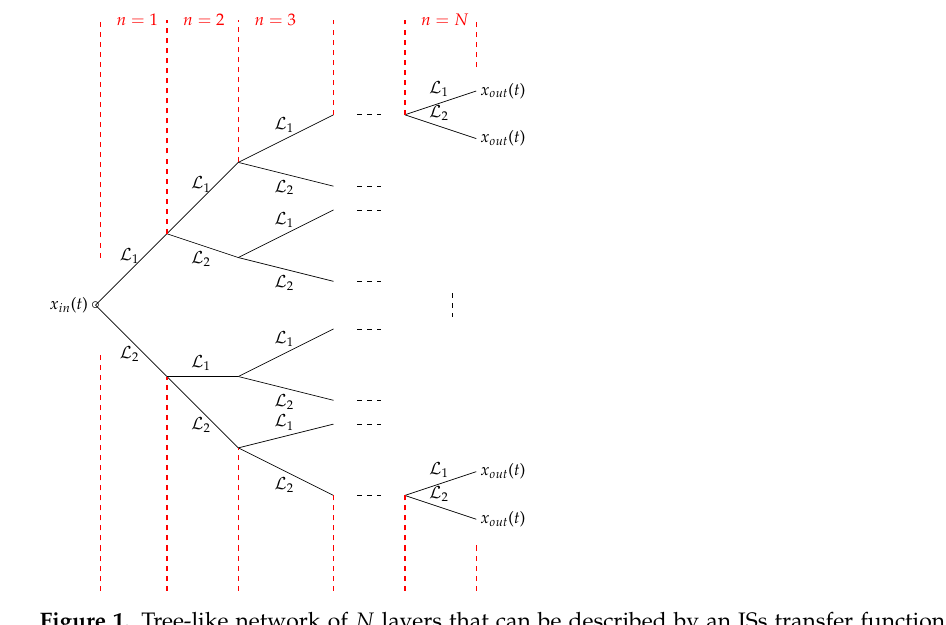
Figure 1. Tree-like network of N layers that can be described by an ISs transfer function. In the network, it is necessary to have L ∞ and L ∈ to be linear operators. Note that all end-points x out are in the same position. The movement is in